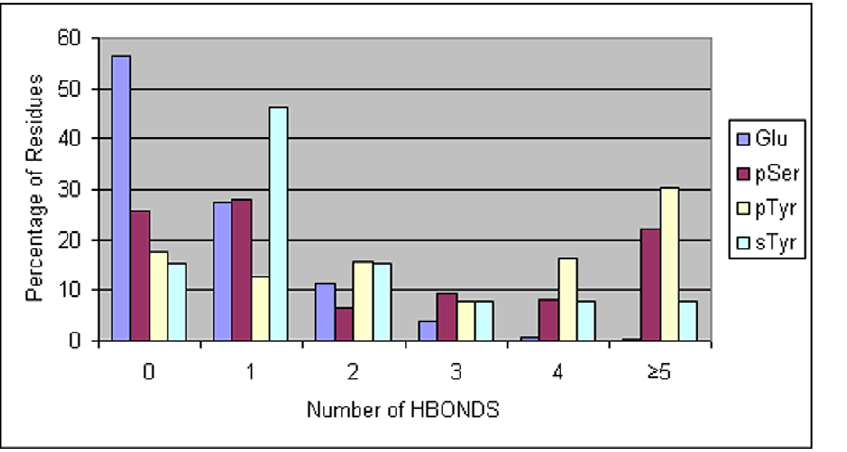
Figure 3. Percentage of Glu, pSer, pTyr and sTyr residues showing a given number of hydrogen bonds. Residues were drawn from all structures in the Protein Databank containing a pSer, pTyr, or sTyr residue. For Glu, residues were taken from the set of structures containing a pSer residue.